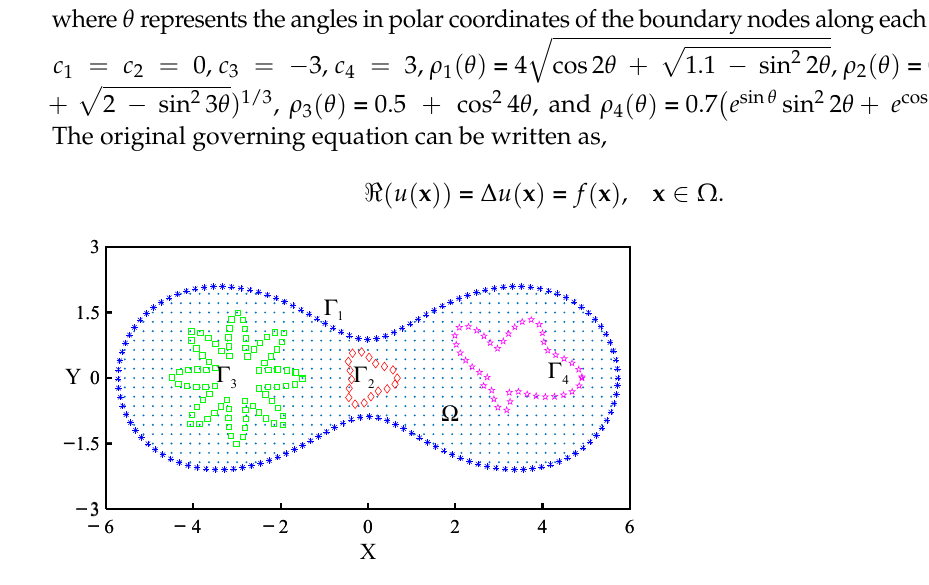
Figure 9. Collocation nodes’ distribution.